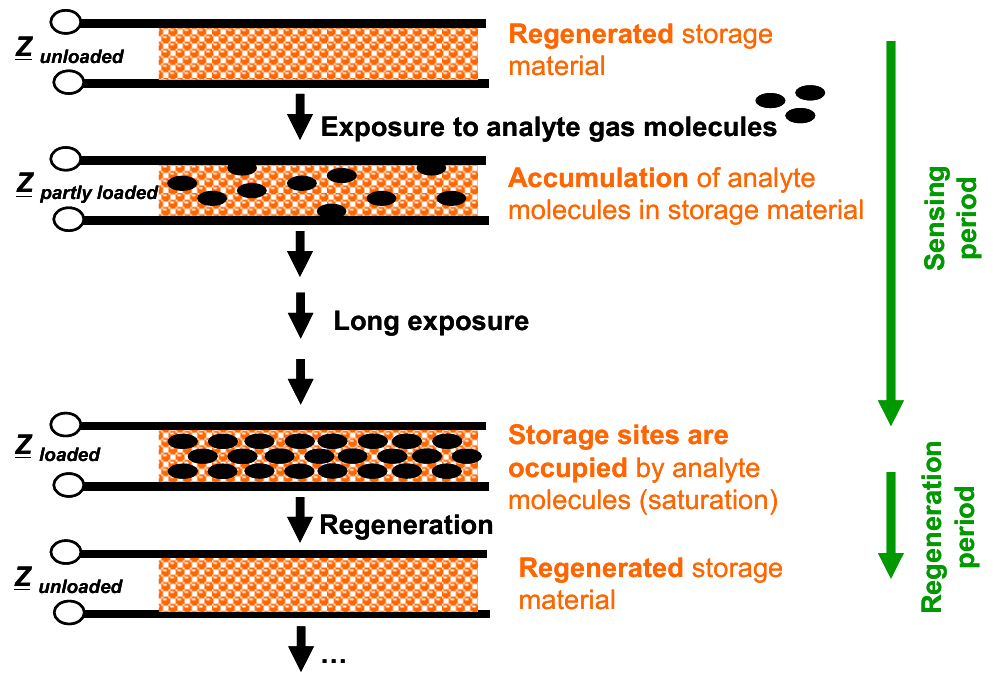
Figure 1. Operation scheme of accumulating-type gas sensors: Long sensing periods (successive accumulation of the analyte molecules in the sensitive layer) alternate with short regeneration intervals (recovery of storage capacity to avoid saturation effects). Here, the complex impedance, Z , is